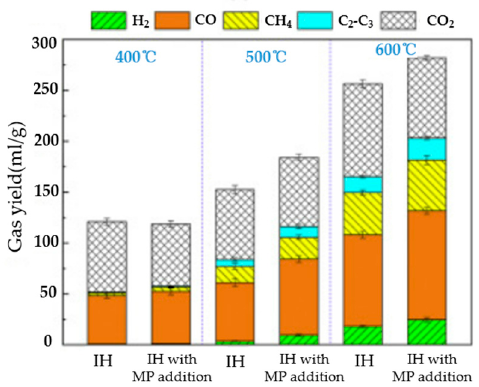
Figure 16. Graph of gas content generated by straw pyrolysis at different temperatures [97].